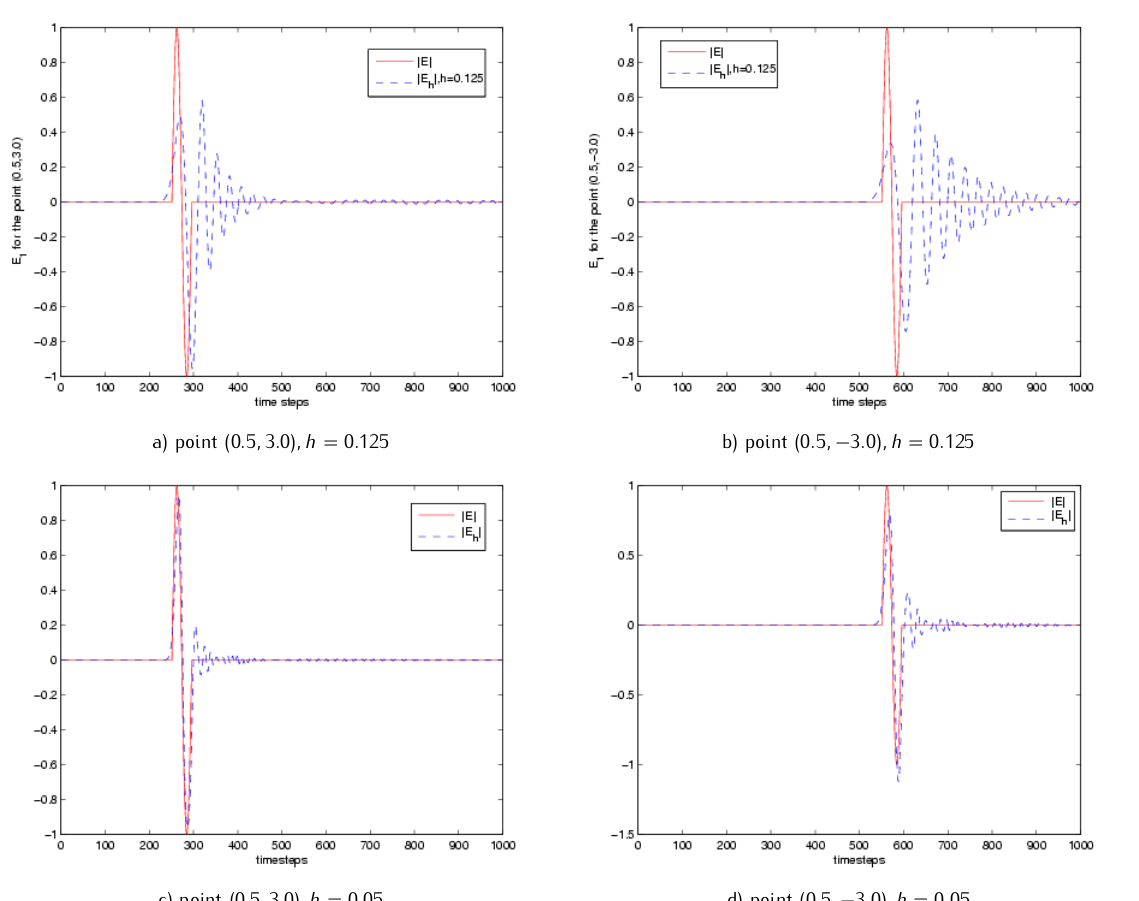
Figure 14. Test 3. Comparison of the analytic and computed solutions in the domain decomposition FEM/FDM during time T = (0 , 20) with ε = µ = 1 . We show computed domain decomposition solutions on different meshes with mesh sizes h : a) on the mesh with ; b) on the mesh with h = 0 . 125 h = 0 . 125 at the point (0 . 5 , 3 . 0) , which is located at the upper part of the computational domain Ω FEM at the point (0 . 5 ,− 3 . 0) , which is located at the lower of Ω ; c) for the mesh size h = 0 . 05 at the point (0 . 5 , 3 . 0) ; d) for the mesh size FEM h = 0 . 05 at the point (0 . 5 ,− 3 . 0)